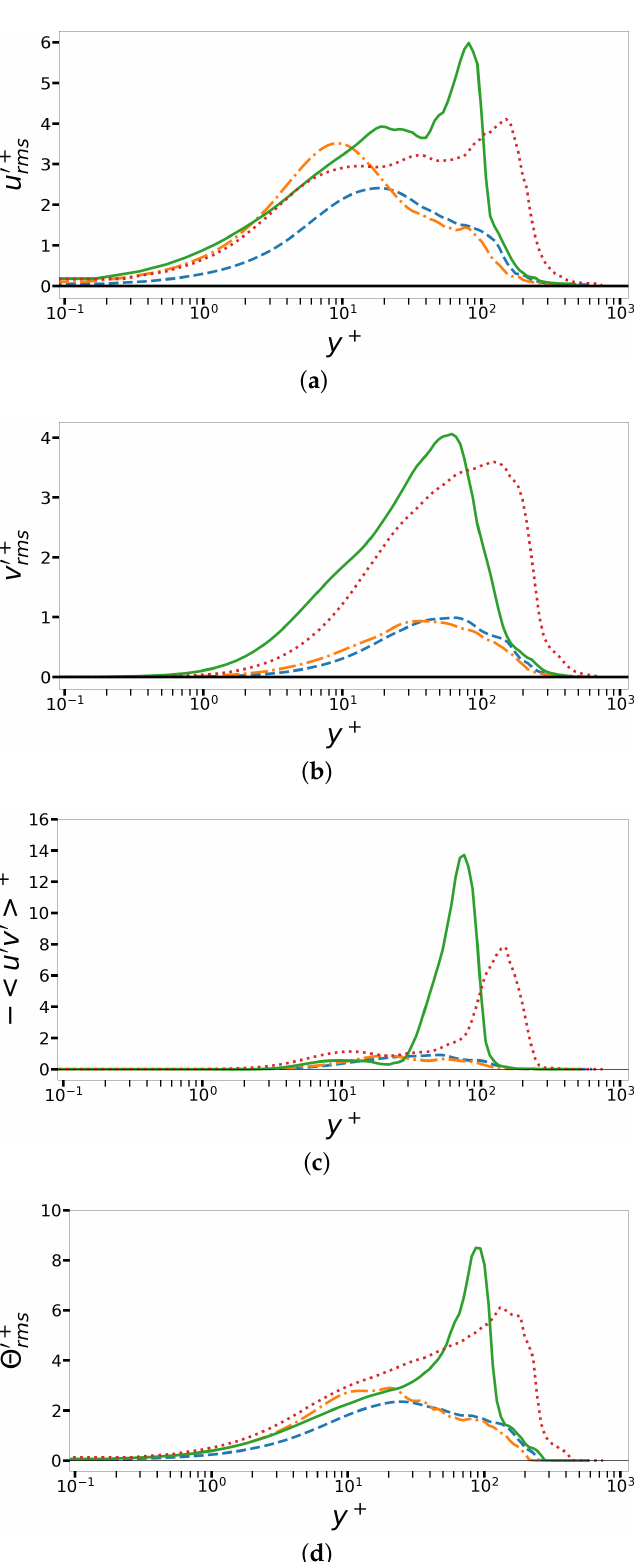
Figure 15. CASE 2: ( a ) RMS of streamwise velocity fluctuations, ( b ) RMS of wall-normal velocity fluctuations, ( c ) shear Reynolds stresses, and ( d ) RMS of thermal fluctuations (profiles as in the legend of Figure